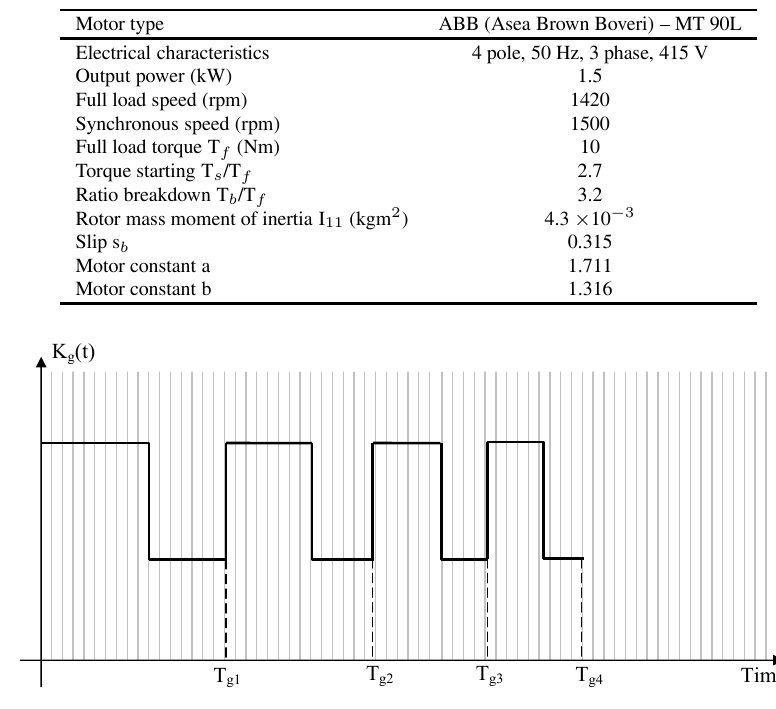
Fig. 4. Evolution of the gearmesh period of a decreasing rotational frequency n r 1